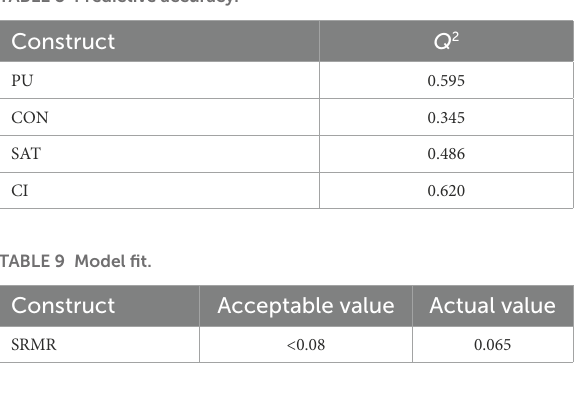
TABLE 8 Predictive accuracy.